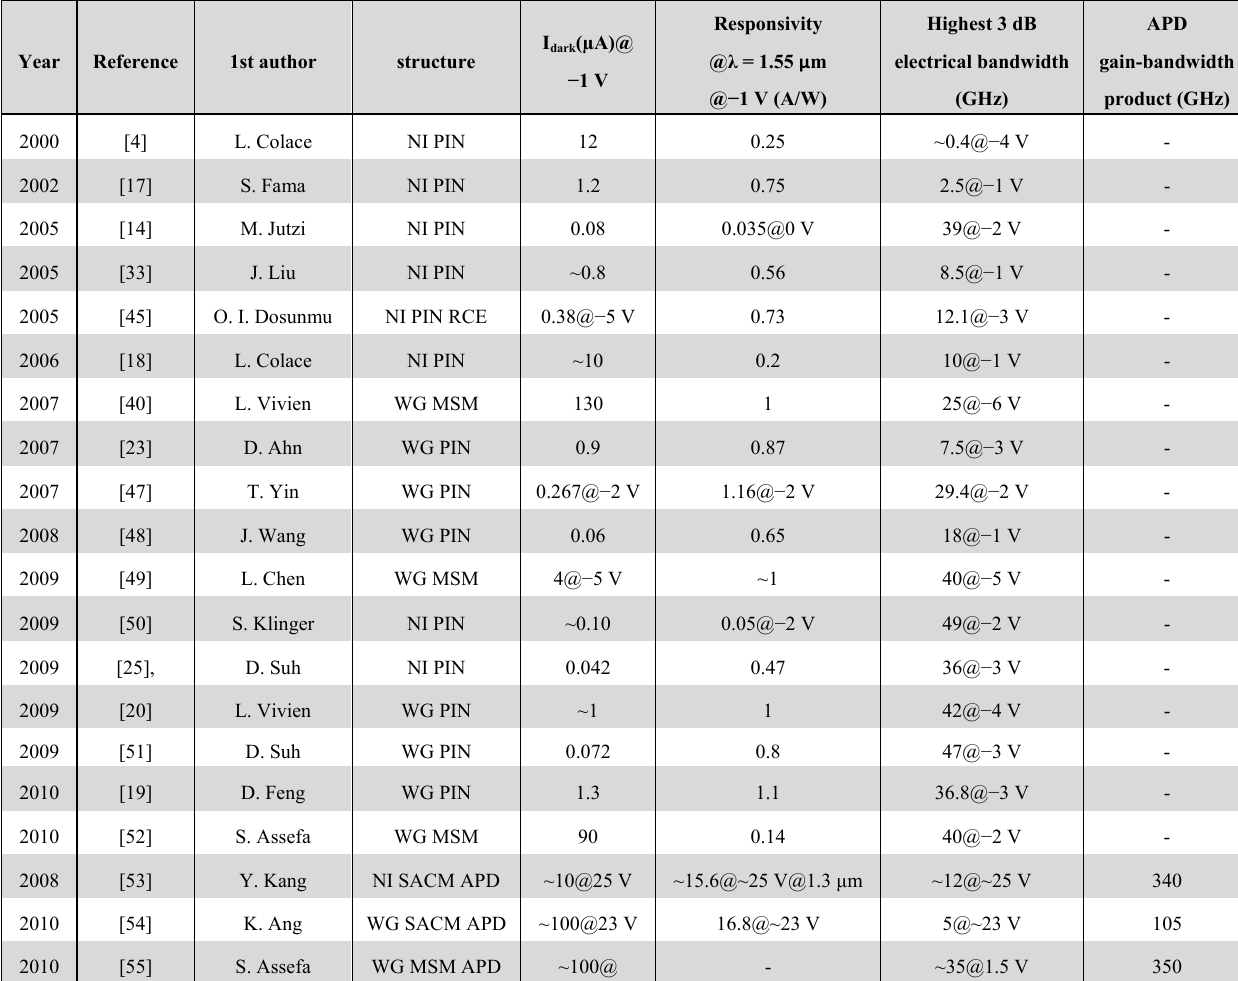
Table 2. Summary of performances from selected Ge